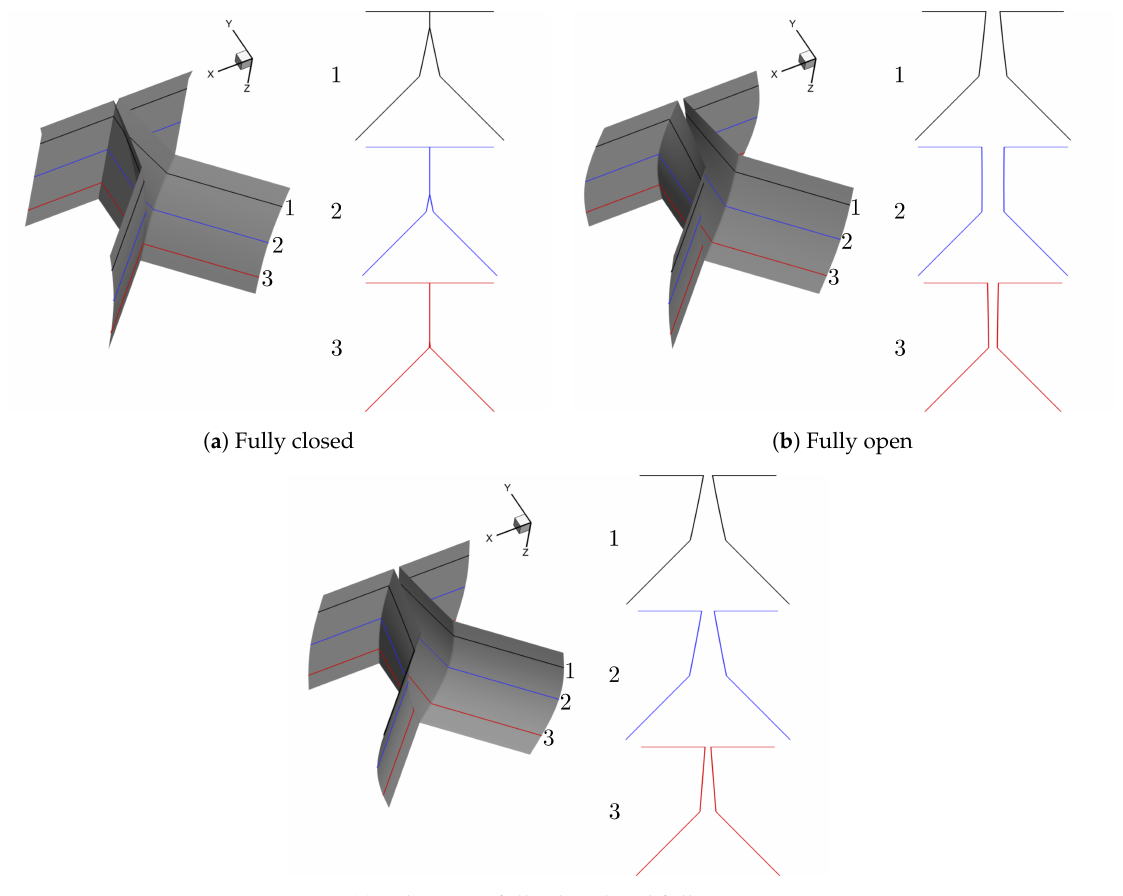
Figure 3. Representative convergent shape (For each representative shape, three planar surfaces in the x − y plane are extracted along the anterior-posterior ( z ) direction to give a detailed view of the glottis shape and the number of each planar surface is denoted as 1, 2, 3 from the anterior to the posterior direction, respectively).